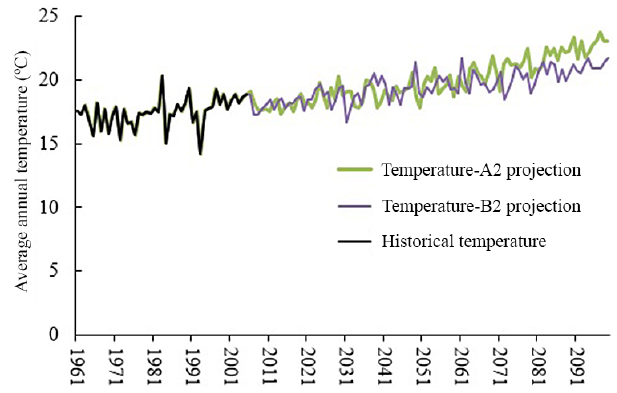
Figure 2. The average temperature in A2 and B2 scenarios for the synoptic station in Tehran.